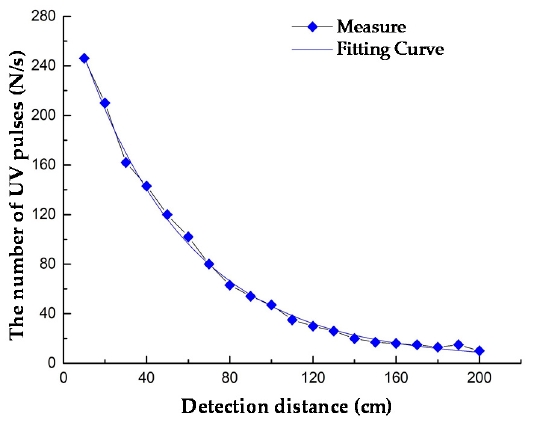
Figure 13. Detection distance and the number of UV pulses (D = 3 cm, U = 12 kV).